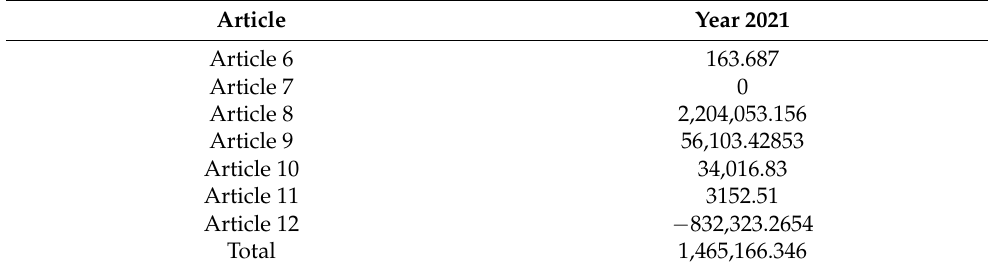
Table 1. The annual volumes lost in the atmosphere (source: